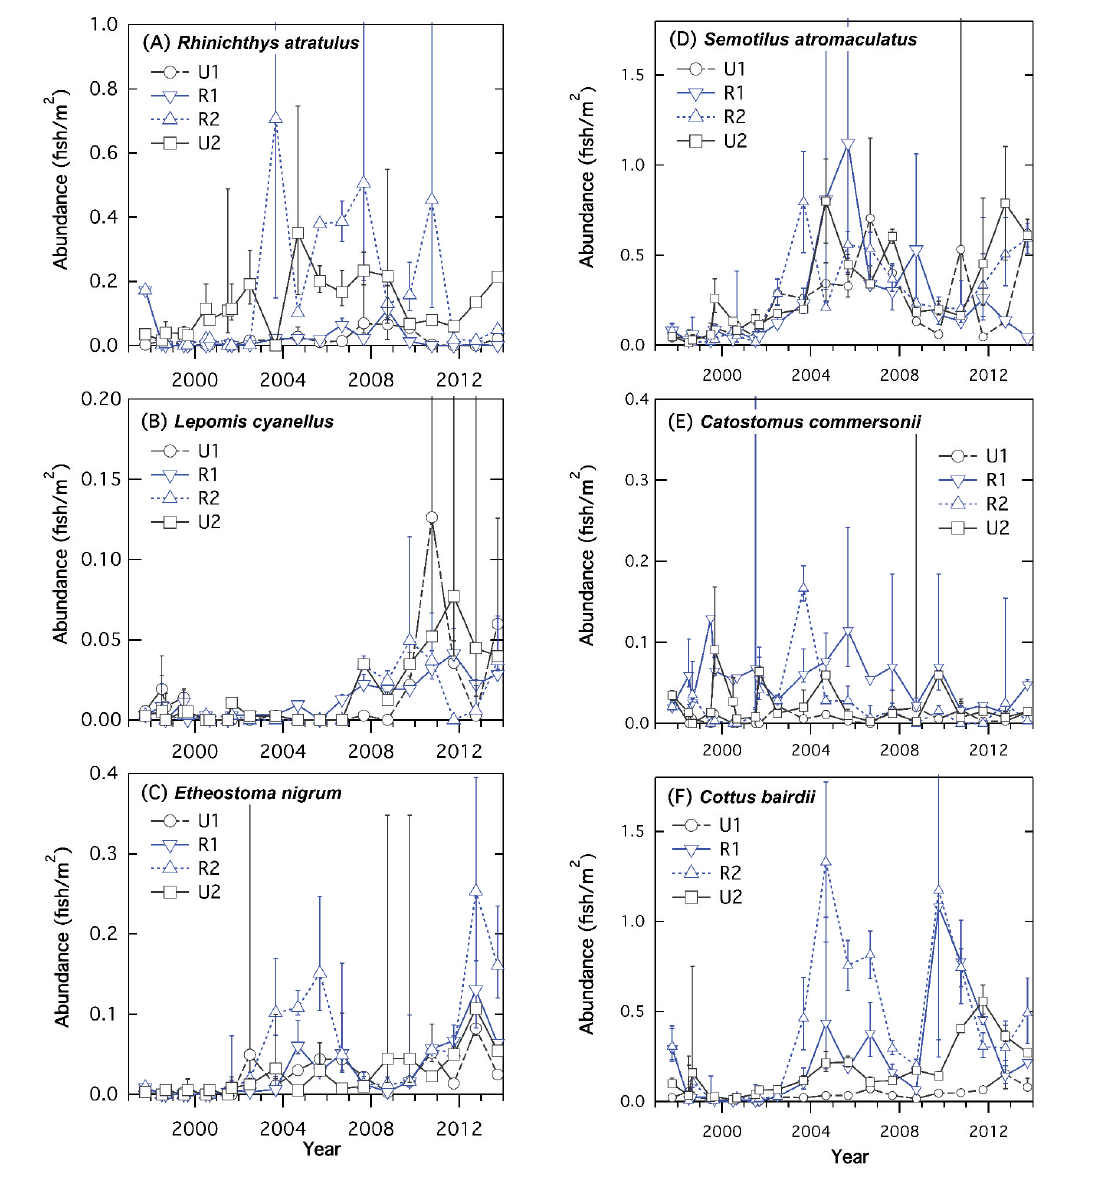
Fig. 6 . Population estimates of six species that were recorded for all 17 years of monitoring using multiple-pass data for each 60-m reach of Juday Creek: (A) blacknose dace, (B) green sunfish, (C) Johnny darter, (D) creek chub, (E) white sucker, and (F) mottled sculpin. Error bars indicate 95% confidence